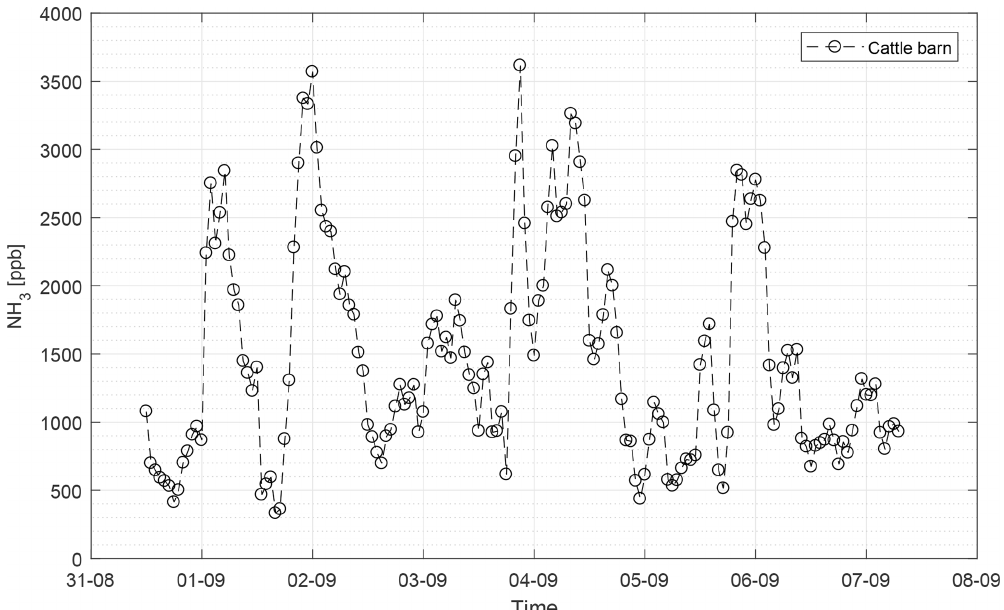
Figure A3. Hourly mean concentrations of NH 3 from a dairy cattle barn, unpublished